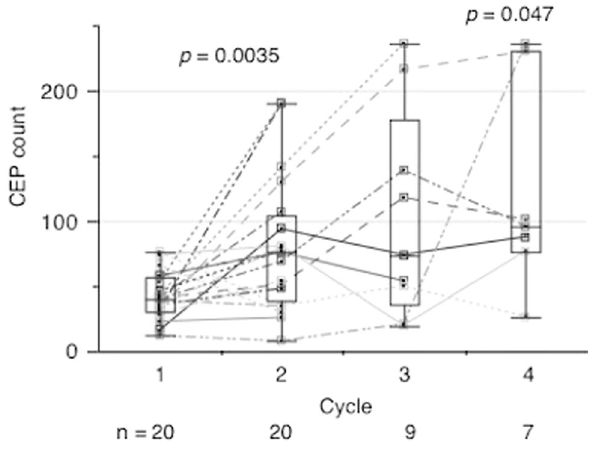
Fig. 2 Alteration in CEP counts during neoadjuvant chemotherapy. The y-axis indicates CEP counts. The number of CEPs increased during neoadjuvant chemotherapy (pre-1st vs. pre-2nd cycle, p = 0.0035; pre-1st vs. pre-4th cycle, p = 0.047, Wilcoxon signed-rank test